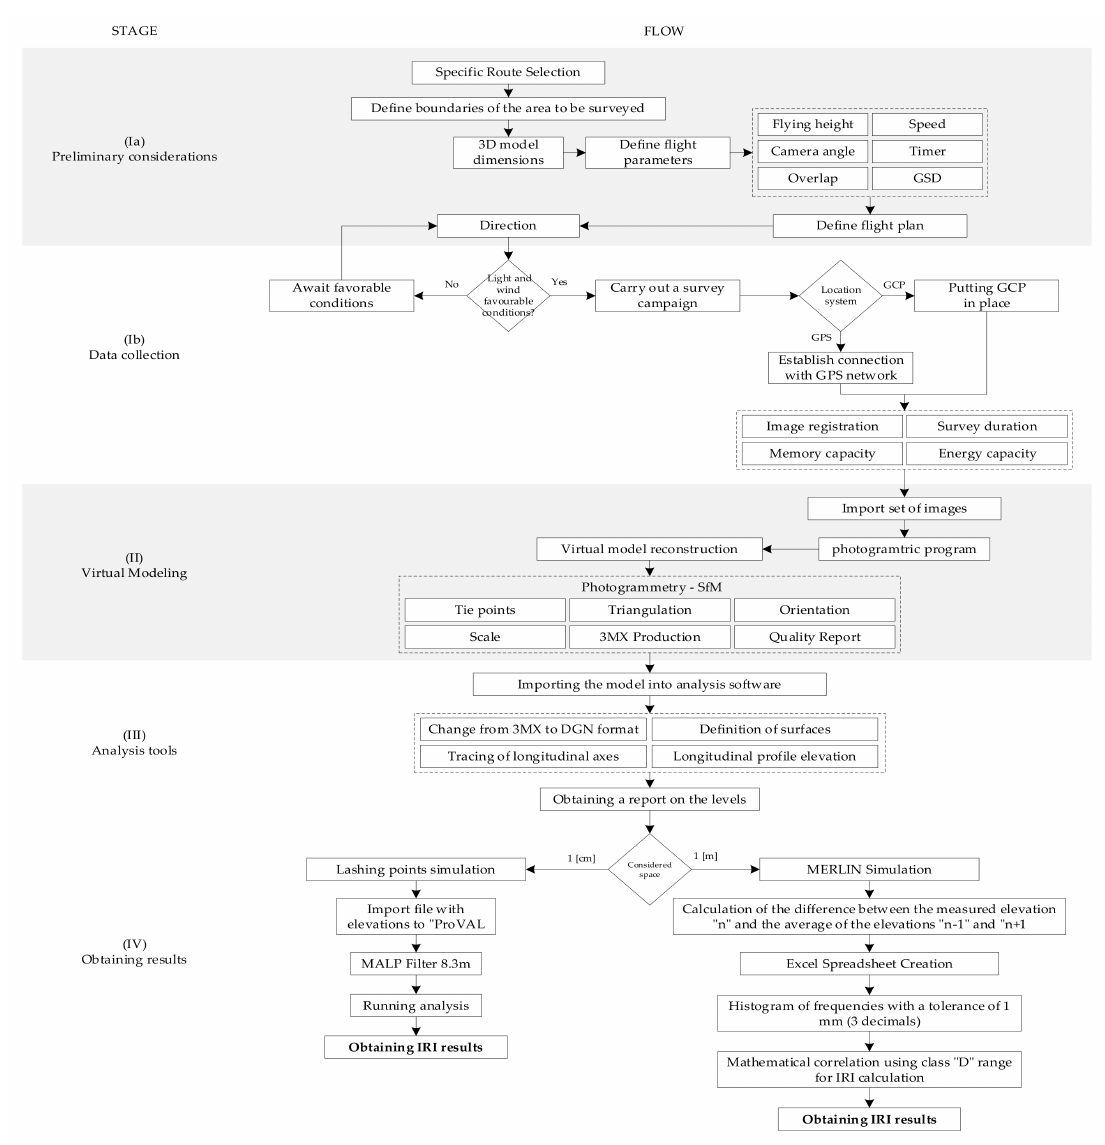
Figure 2. Proposed